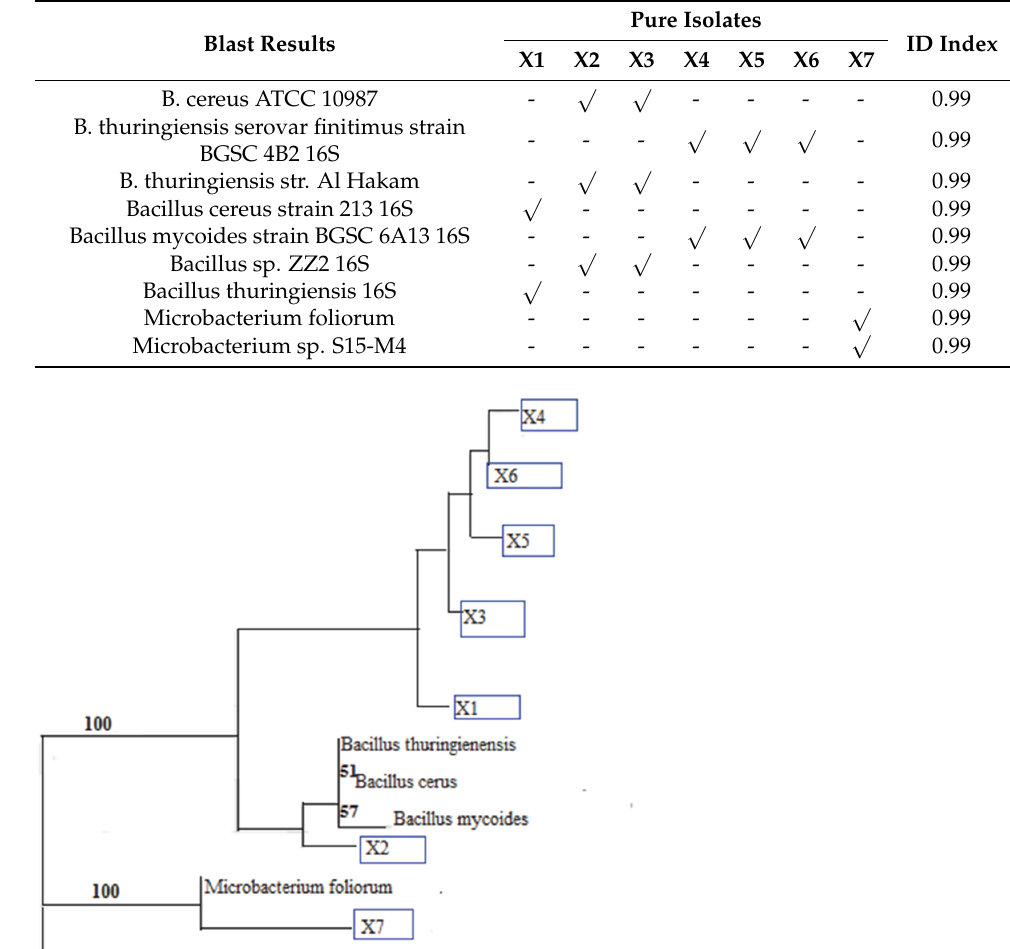
Table 3. Sludge Cr(VI)-Reducing Bacteria strain characterisation using 16S rRNA [3].